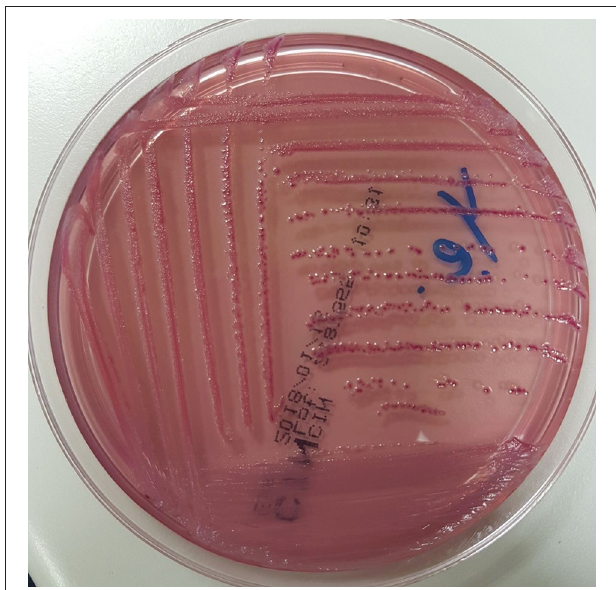
FIGURE 2 | Y. enterocolitica on CIN agar: small colonies with the typical red bull’s eye appearance, namely a red center with colorless translucent rim.